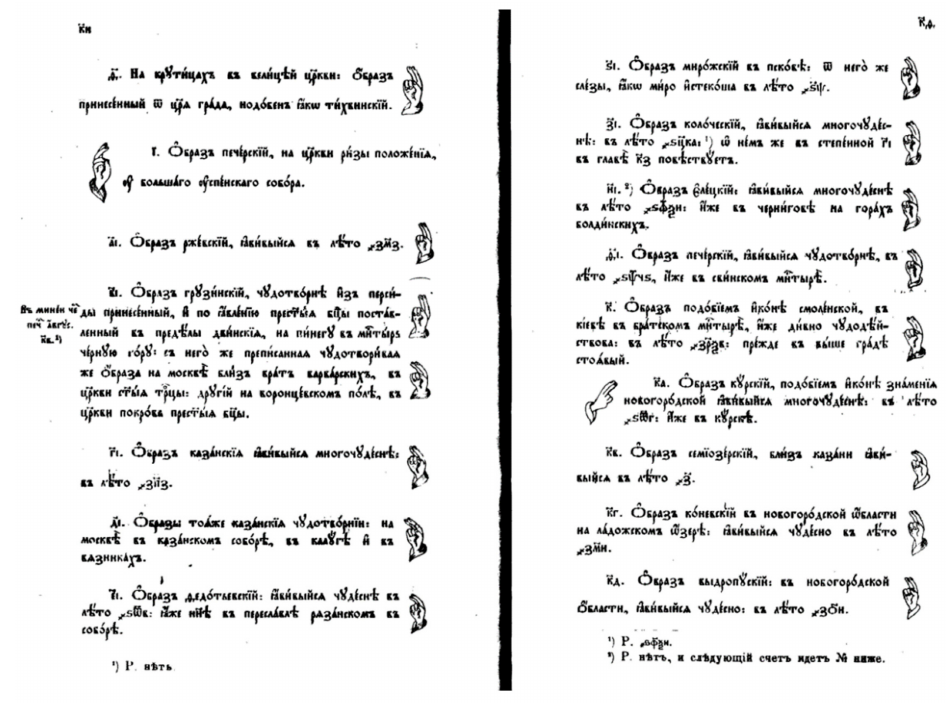
Figure 4. Diakonovy otvety ( Ответы A лекс a ндр a Д ia к o н a , 1719), Беспл a тн o е прил o жение к Figure 4. Diakonovy otvety ( Ответы Александра Д i акона , 1719), Бесплатное приложение к журналу журн a лу “C т a р oo брядец ” [Besplatnoe priloženie k žurnalu “Staroobrjadec”], 1906, pp. 30–31. Figure 4. Diakonovy otvety ( Ответы Александра Д i акона , 1719), Бесплатное приложение к журналу “ Старообрядец ” [Besplatnoe priloženie k žurnalu “Staroobrjadec”], 1906, pp. “ Старообрядец ” [Besplatnoe priloženie k žurnalu “Staroobrjadec”], 1906, pp. 30–31. Figure 4. Diakonovy otvety ( Ответы Александра Д i акона , 1719), Бесплатное приложение к журналу “ Старообрядец ” [Besplatnoe priloženie k žurnalu “Staroobrjadec”], 1906, pp. 30–31.